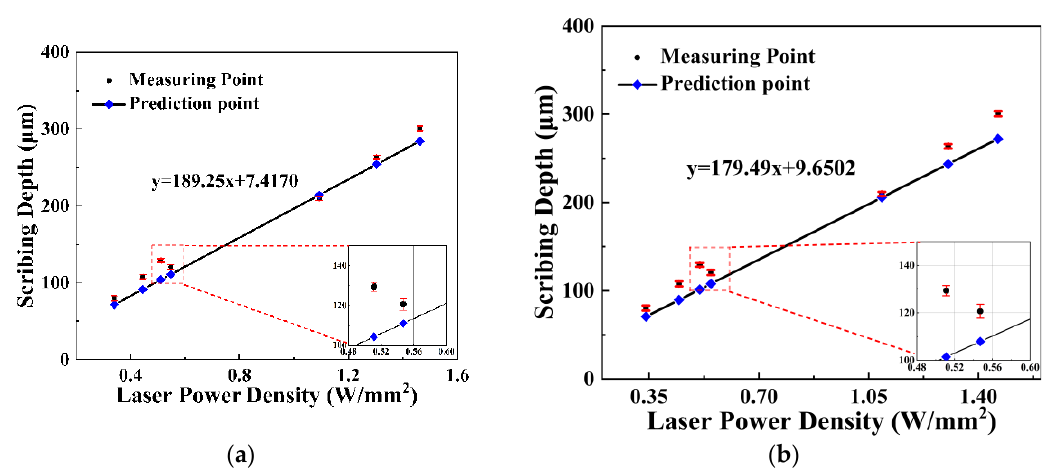
Figure 13. Accuracy of mathematical equations. ( a ) Accuracy of mathematical Equation (13); ( b ) Accuracy of mathematical Equation (14).